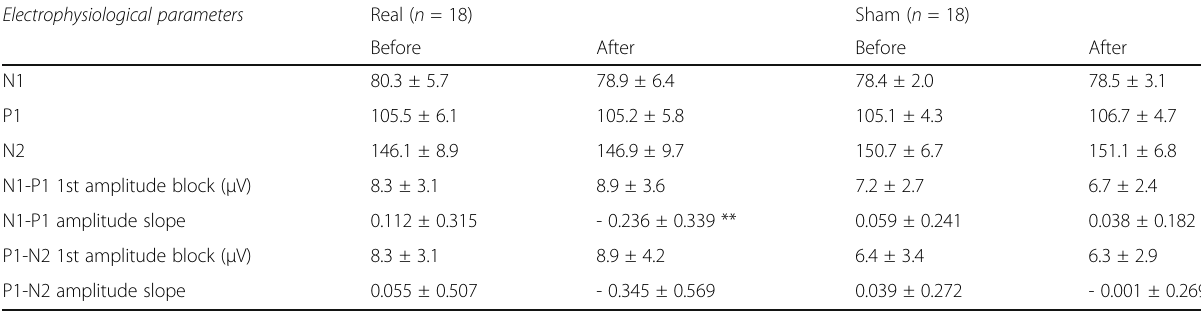
Data are expressed as means ± SD. ** = p < 0.01 before vs. after the